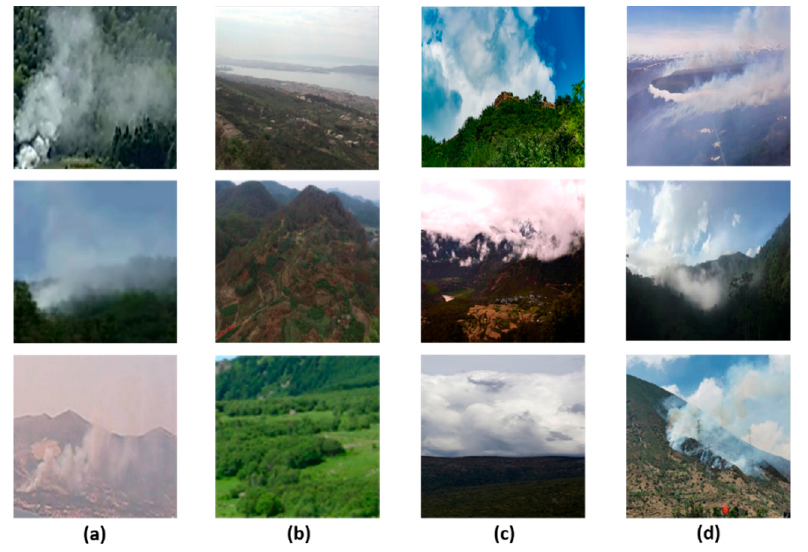
Figure 10. Samples of four cases: ( a ) true positive; ( b ) true negative; ( c ) false positive; ( d ) false neg ‐